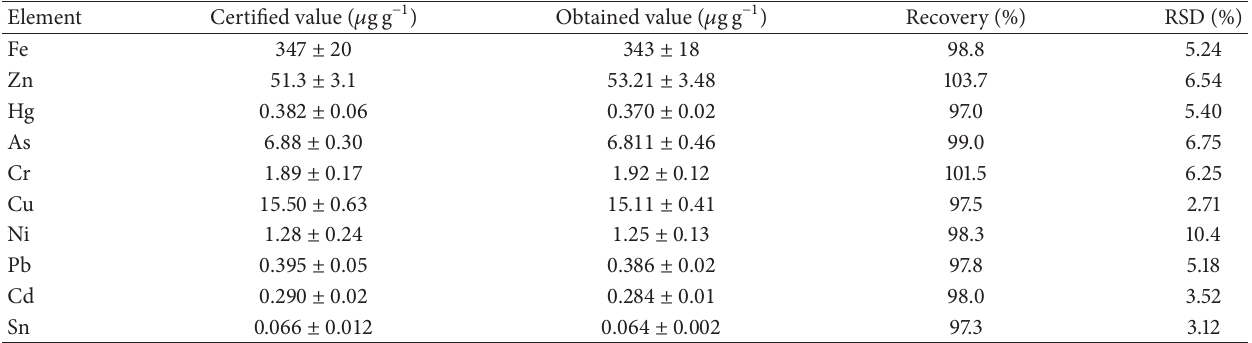
Table 3: Reference material recovery study.